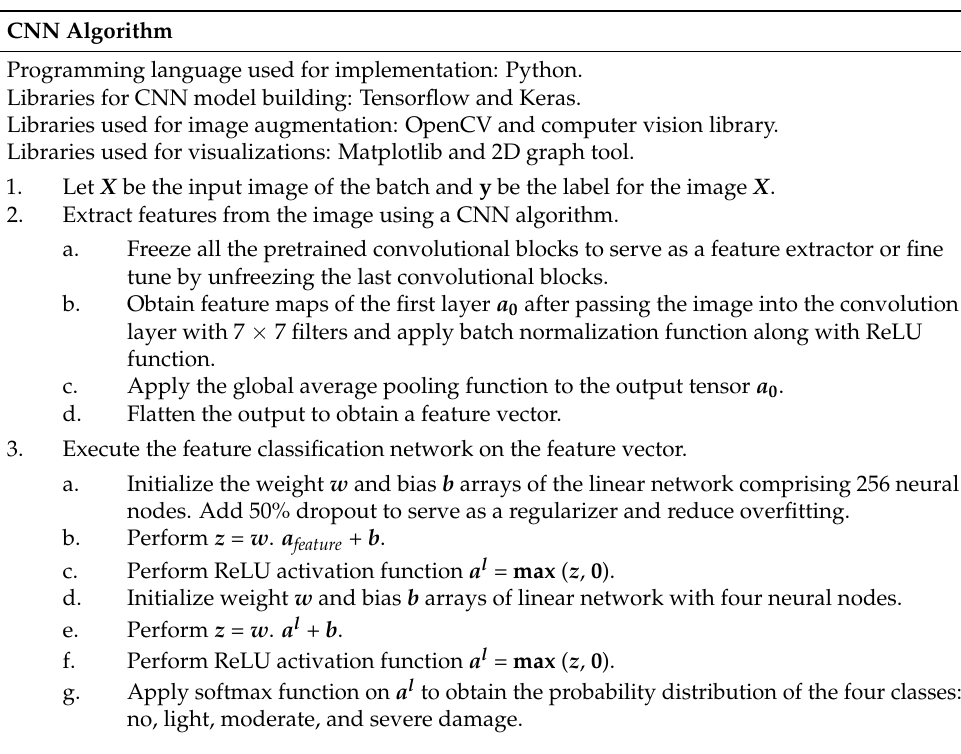
Table 3. CNN model algorithm